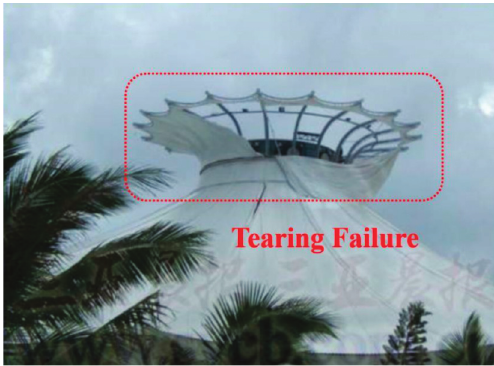
Figure 1: Postfailure cultural exhibition center in